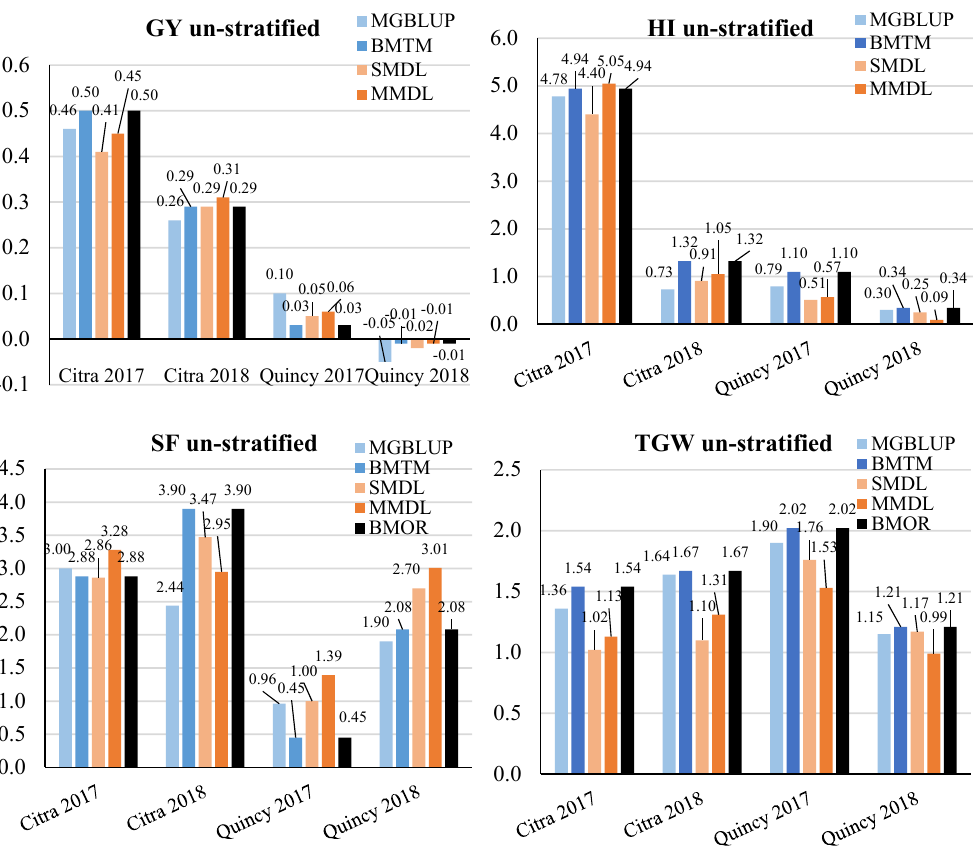
Figure 6. Prediction accuracies for GY (t ha − 1 ), HI (%), SF (grains/g chaff weight), and TGW (g) across environments using the BMOR model. GY, grain yield; HI, harvest index; SF, spike fertility; TGW, thousand grain weight. Mean Pearson’s correlations and standard error for each environment were presented for each trait. The results of GY, HI, SF, and TGW trait were colored in orange, blue, light green, and blue-gray.